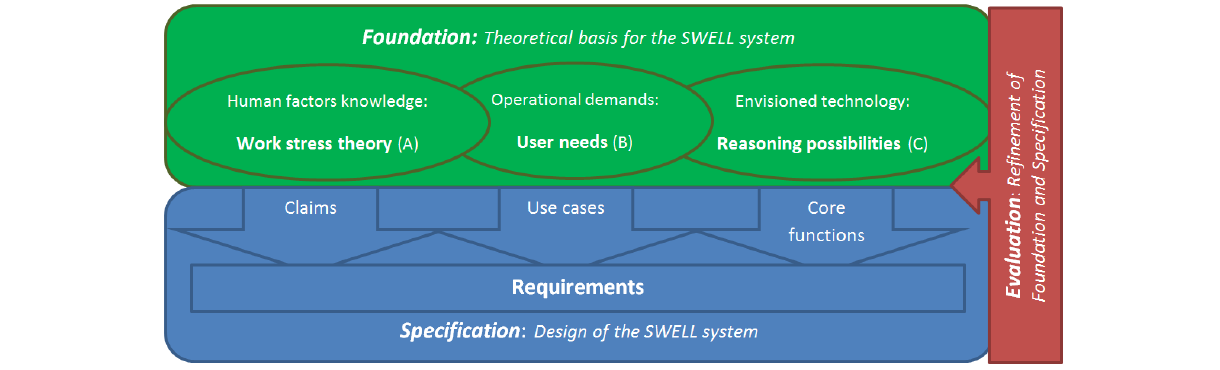
Figure 1. Situated Cognitive Engineering (sCE) approach.